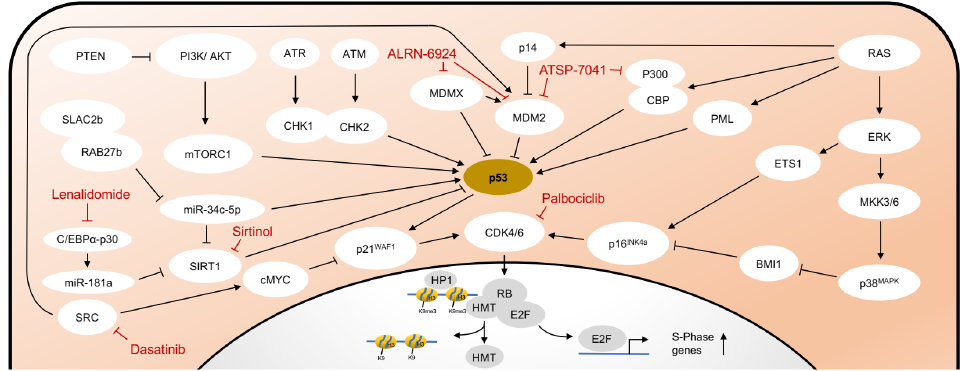
Figure 1. Pathways in cellular senescence. Schematic representation of the major pathways of cellular senescence and selected compounds for senescence induction or senolysis. HMT, Histone methyltransferase. Other abbreviations are explained in the text in detail.